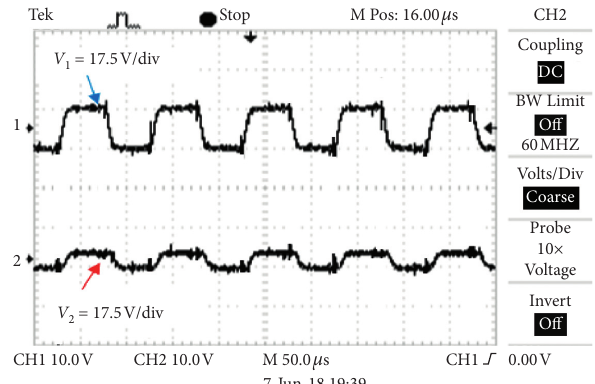
Figure 14: Input V 1 and output V 2 voltages of the ICPT system at 15cm air gap.